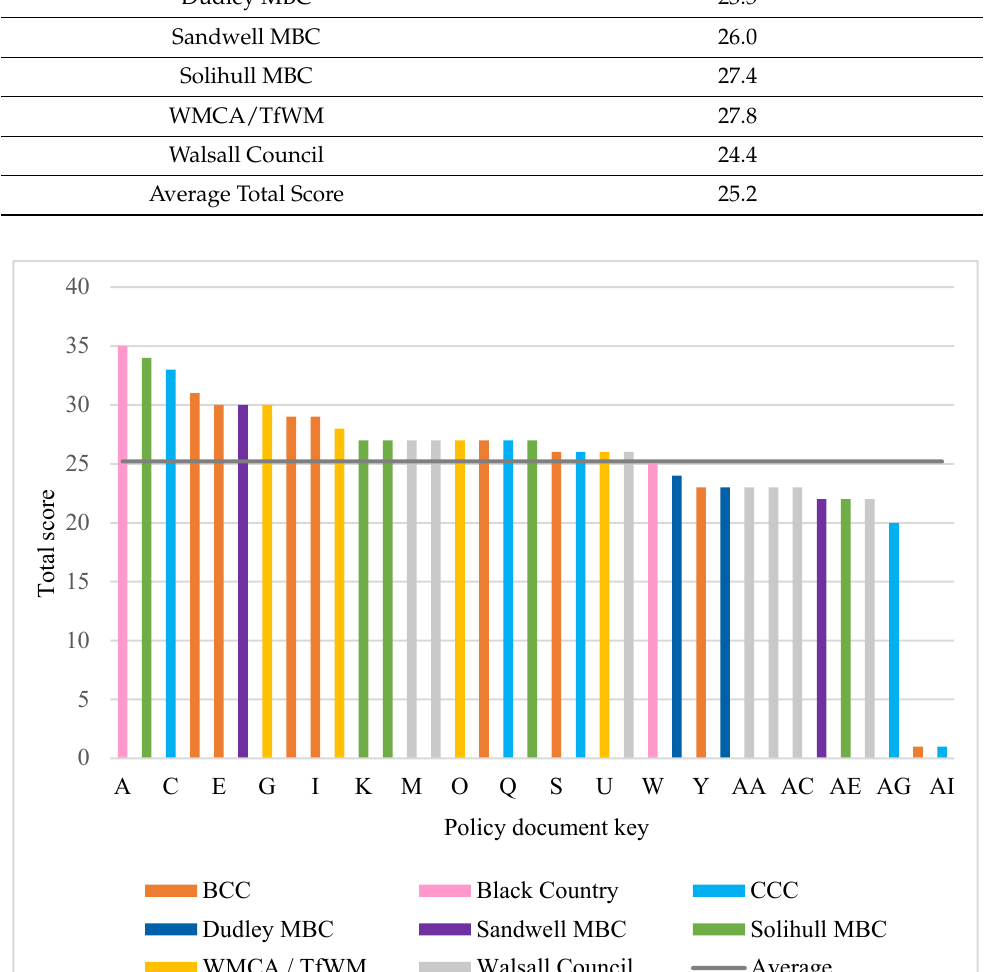
Figure 2. Local authority/organisation against total score.